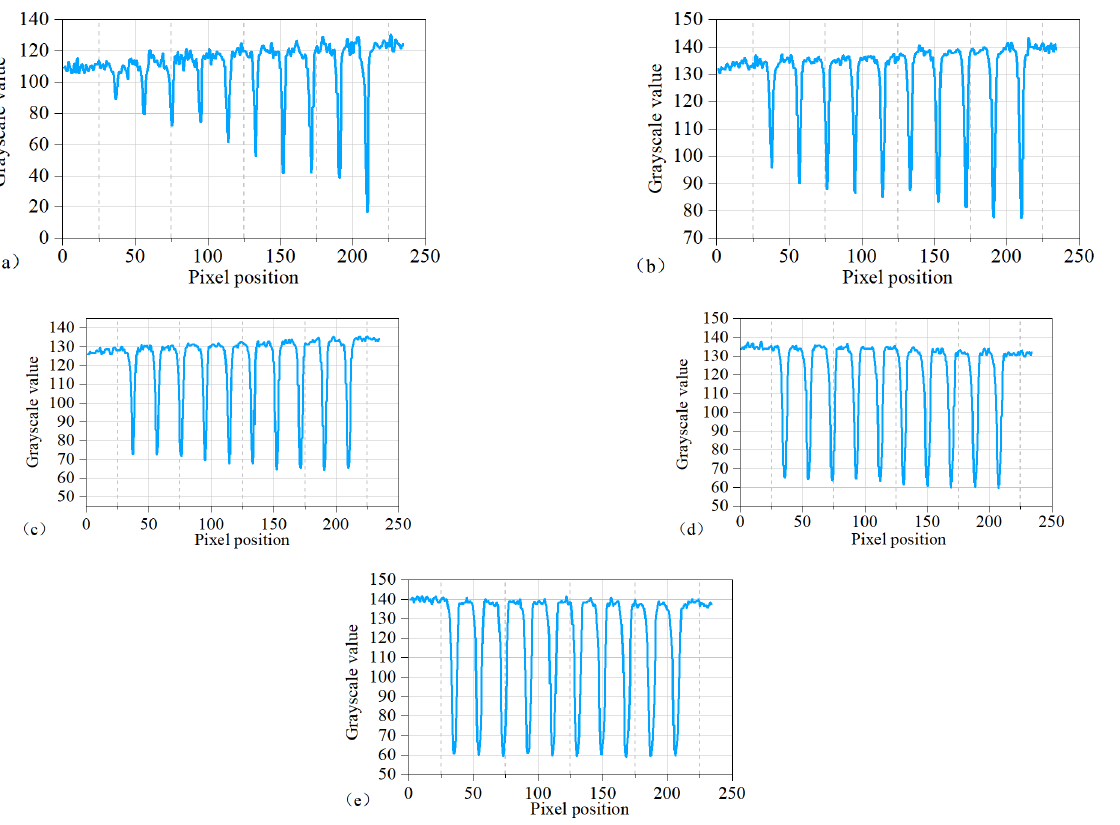
Figure 8. Grayscale distribution map of the crack width direction: ( a ) series of 0.1–1.0 mm, ( b ) series of 1.1–2.0 mm, ( c ) series of 2.1–3.0 mm, ( d ) series of 3.1–4.0 mm, ( e ) series of 4.1–5.0